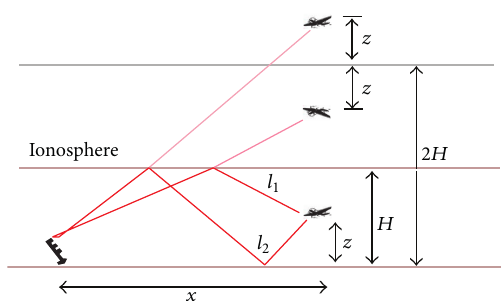
Figure 3: The micromultipath effect in the flat earth